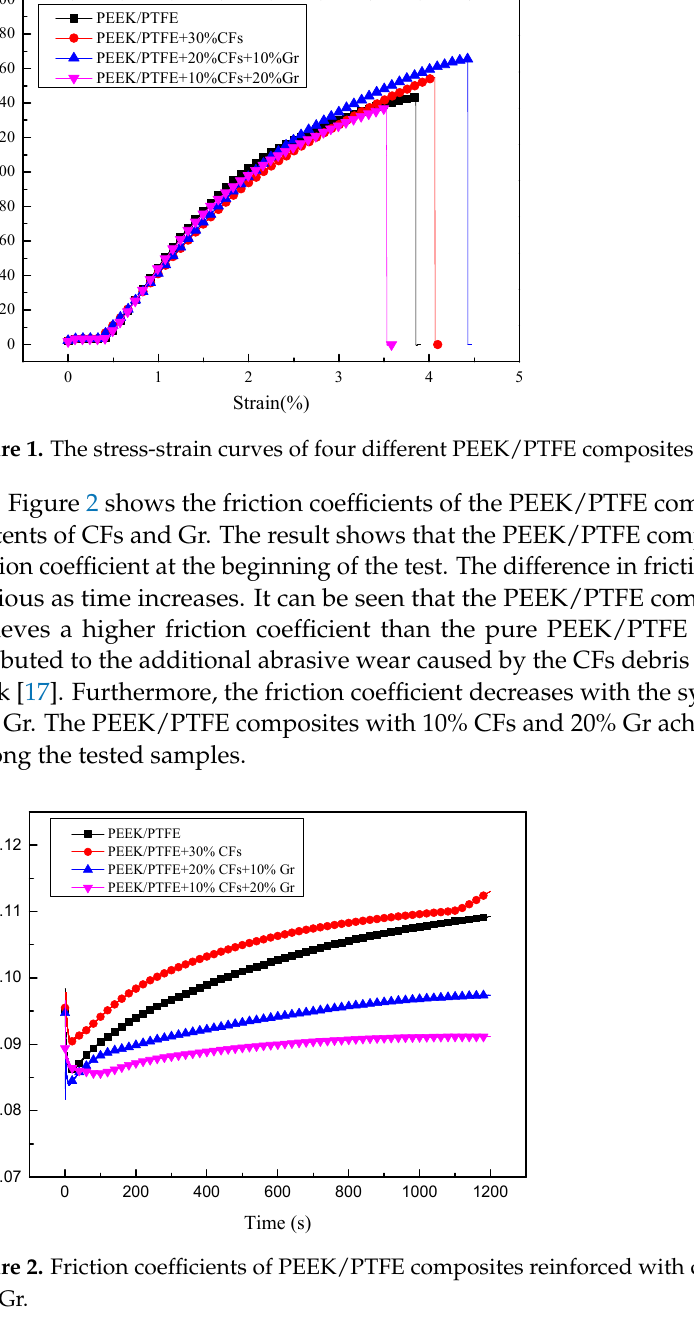
Figure 2. Friction coefficients of PEEK/PTFE composites reinforced with different contents of CFs and Gr.